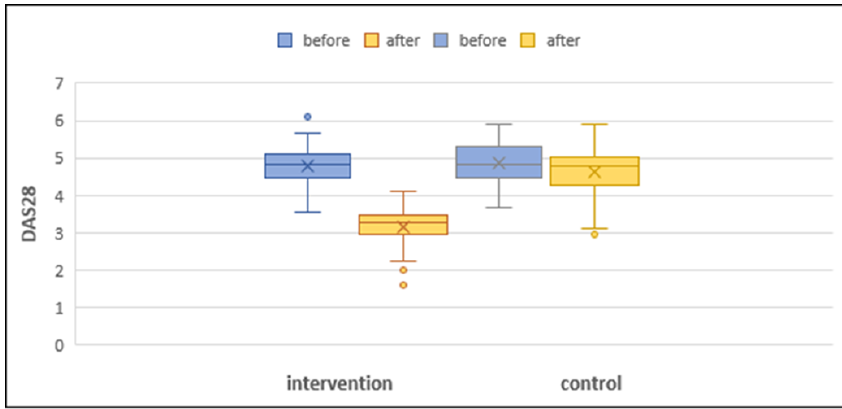
Fig. 5. Boxplot showing change in DAS28 score among the studied groups